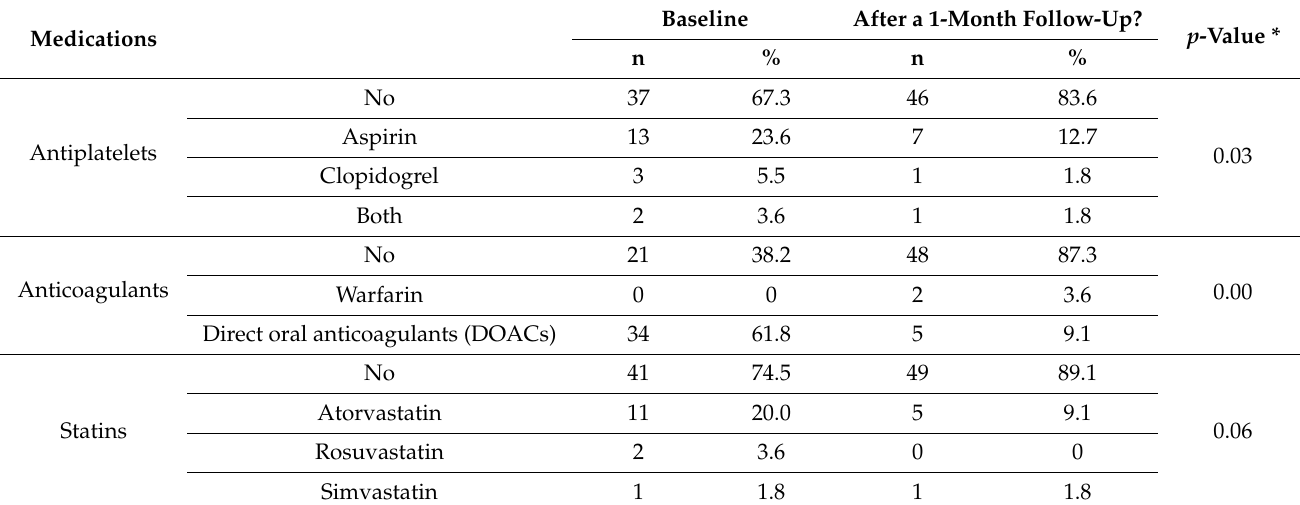
Table 4. Comparison of medications at baseline and after one month.